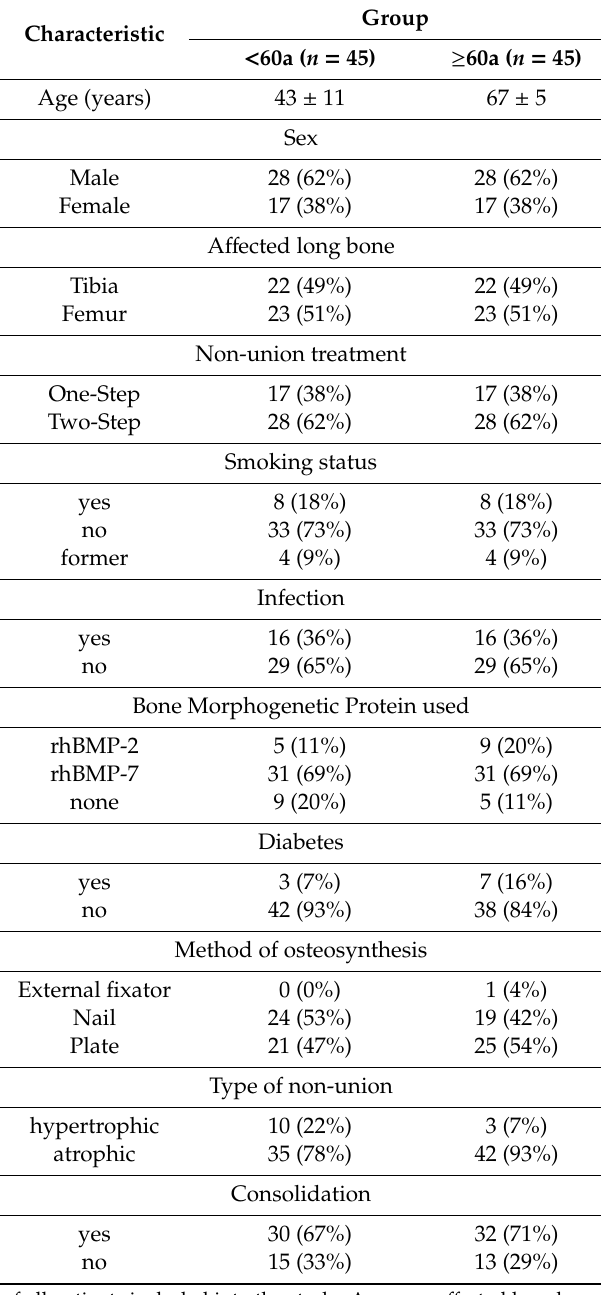
Table 1. Patient